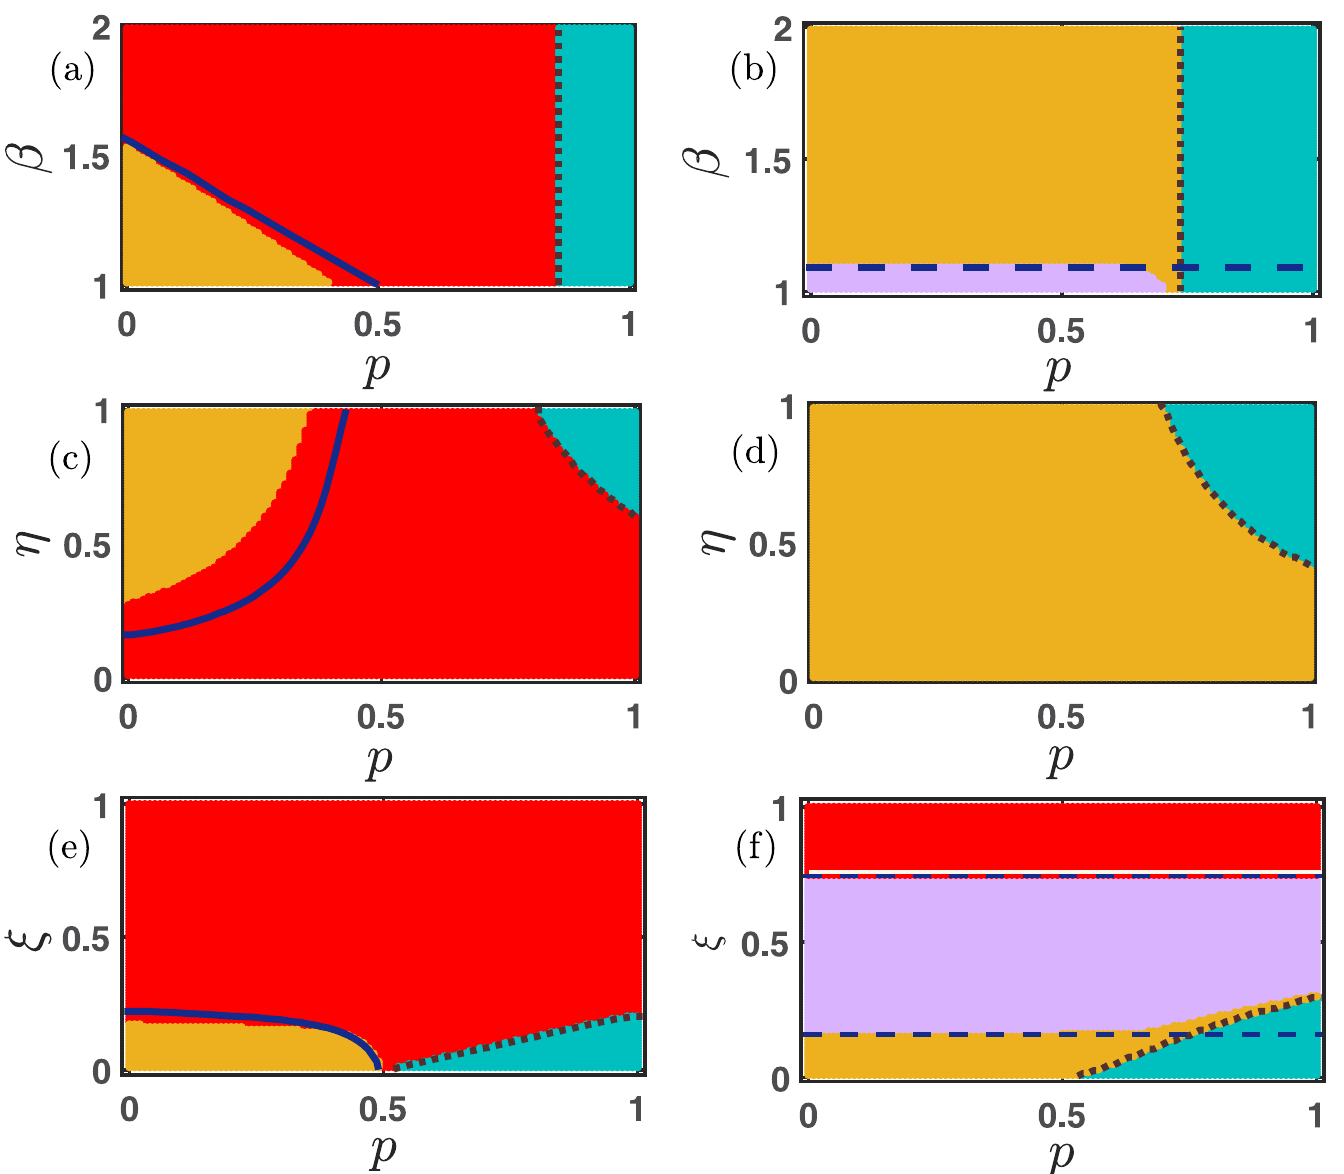
Fig 2. The interplay of different parameters in the mutation-free model (8). p is the probability of playing the PD game. We investigate the role of p in our proposed model (8) in the absence of the mutation. The figures (a), (c), and (e) of the left-handed column are drawn with σ 1 = σ 2 = 0. The remaining figures in the right-hand column are plotted with non-zero values of σ 1 and σ 2 . The advantages provided by the free space help to promote cooperation, as portrayed through the broad area of yellow and violet regions in figures (b), (d), and (f). Red, sea blue, violet, and yellow depict the stable extinct state, cooperator-free state, defector-free state, and co- existence state, respectively. We also plot our calculated curves from the local stability analysis of the stationary points. The white line represents that of E 0 , whereas the blue line portrays that of the coexistence equilibrium E 3 . The brown dotted line is the stability curve for the cooperator-free stationary state E 2 , while the blue dashed line represents that of the defector-free steady state E 1 . The mismatches with the stability curve in a few places are due to the multistable behavior of our constructed model (8). Other parameter values are kept fixed at (a-d) ξ = 0.15, (c-f) β = 1.1, (a,b,e,f) η = 0.85, (b,d,f) σ 1 = 0.75, (b,d,f) σ 2 = 0.25 and μ = 0.